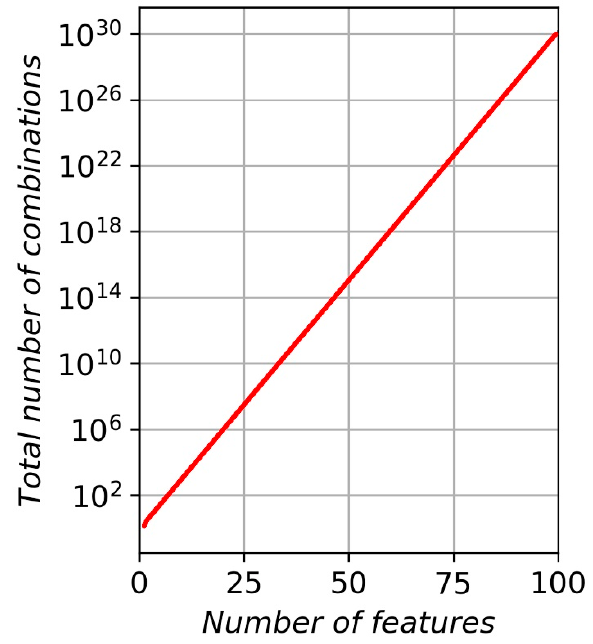
Figure 3. The total number of possible combinations versus the number of features.